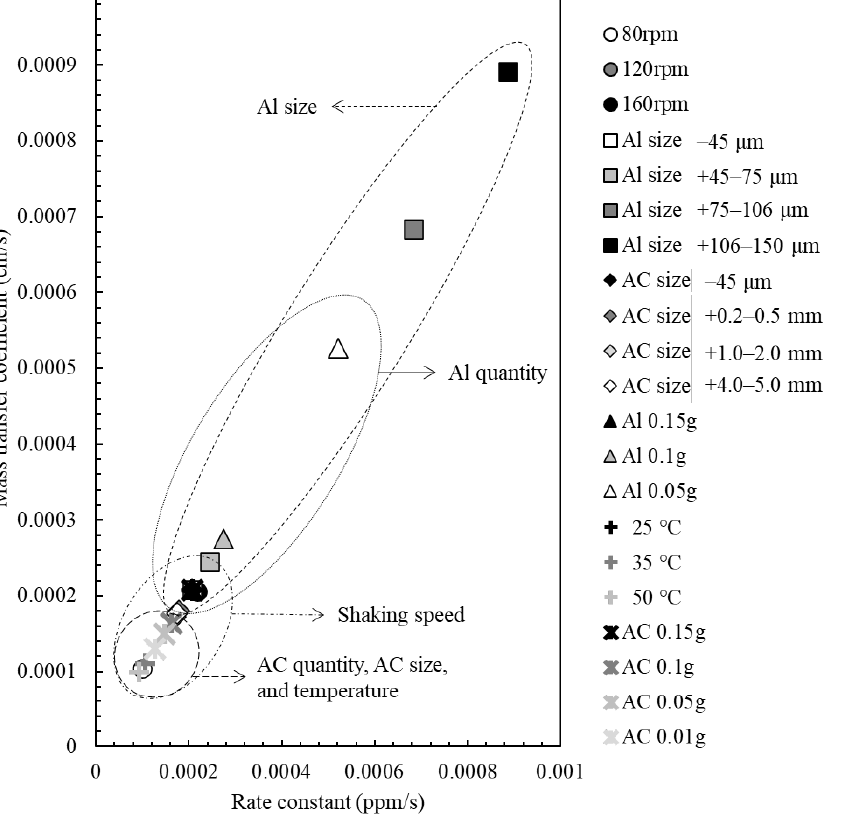
Figure 6. ( a ) The effects of shaking speed on recovery of Au ions, and ( b ) the plot of rate constant/rate vs shaking speed for the cementation reaction by galvanic interaction of Al and AC in ammonium thiosulfate system (Note that reaction rate has a minus value). Table 6. Summary of rate constant for the cementation of Au as a function of shaking speed (base